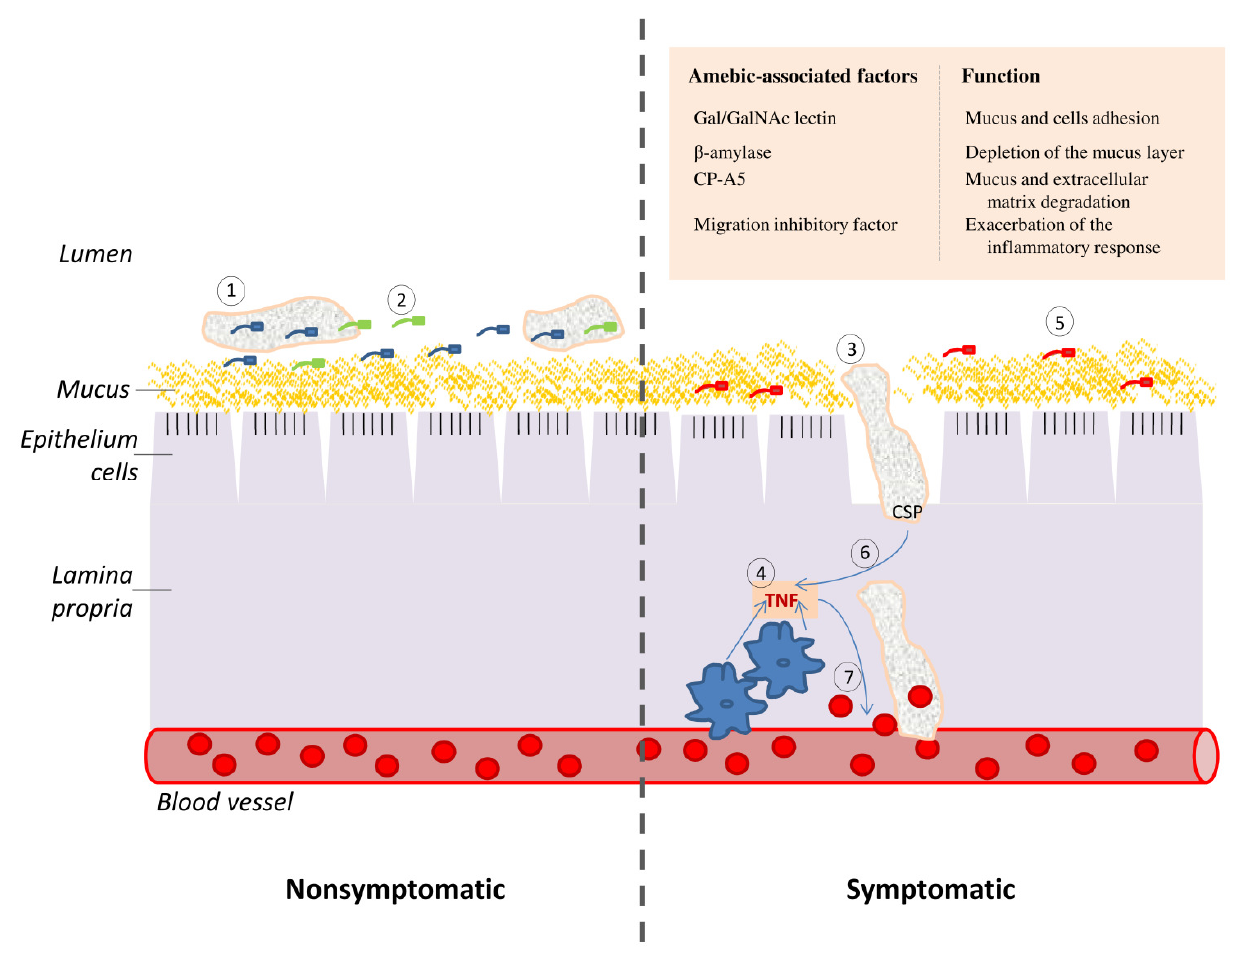
FIGURE 1: TNF and CSP are two essential elements of the cascade of events which lead to amebic colitis. (Left panel) Asymptomatic ame- biasis: (1) Trophozoites are living as nonpathogenic intestinal commensals, without causing any noticeable damage to the host. (2) These trophozoites feed on bacteria and cellular debris that are present in the lumen of the colon and on the surface of the colonic mucus. (Right panel) Symptomatic amebiasis: (3) Trophozoites degrade the mucus layer (involvement of β-amylase [4] and CP-A5 [8] in this process), trig- ger a host inflammatory response and induce the collagen remodeling that is required for invasion of the lamina propria (involvement of CP- A5) [9]. (4) The invasion of the colonic mucosa by E. histolytica generates an acute pro-inflammatory reaction which is characterized by the recruitment of macrophages and the production of the pro-inflammatory cytokines, such as TNF. (5) Inflammation causes change in the gas- trointestinal microbiota [16] and this new flora may be less favorable to the parasite growth. (6) The parasite is attracted to the source of TNF production and CSP is essential for this process. (7) TNF increase vascular endothelial permeability [18] and consequently provides the parasite with an access to erythrocytes. These erythrocytes may represent a better source of nutriment for the parasite than the bacterial flora that is associated with